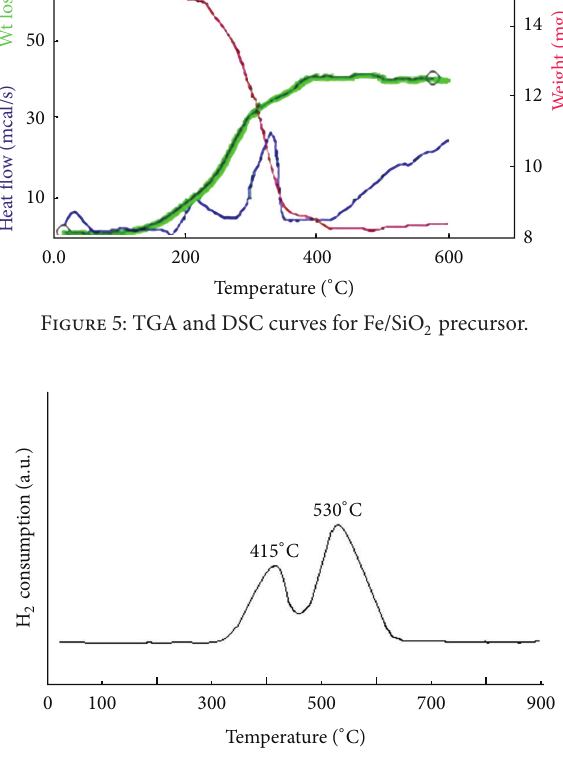
represents the removal of the physically adsorbed water and ethanol from the material. The endothermic peaks around 230–370 ∘ C and 280–530 ∘ C are due to the decomposition of hydroxyl and phases,